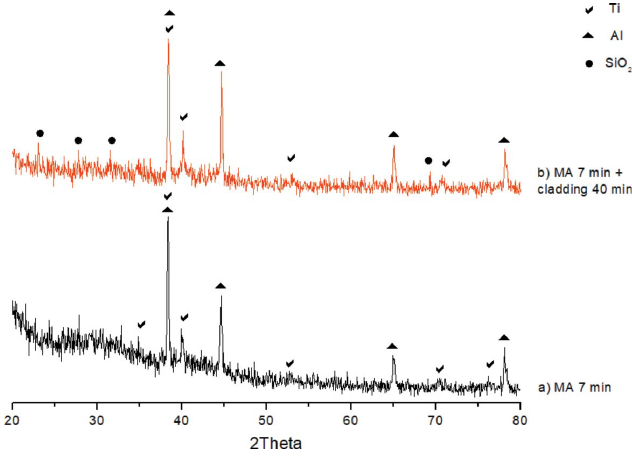
Figure 1 Diffractograms of the Ti (64 wt%.) + Al mechanocomposite ( a , bottom) and the mechanocomposite after cladding with SiO 2 target ( b , top)